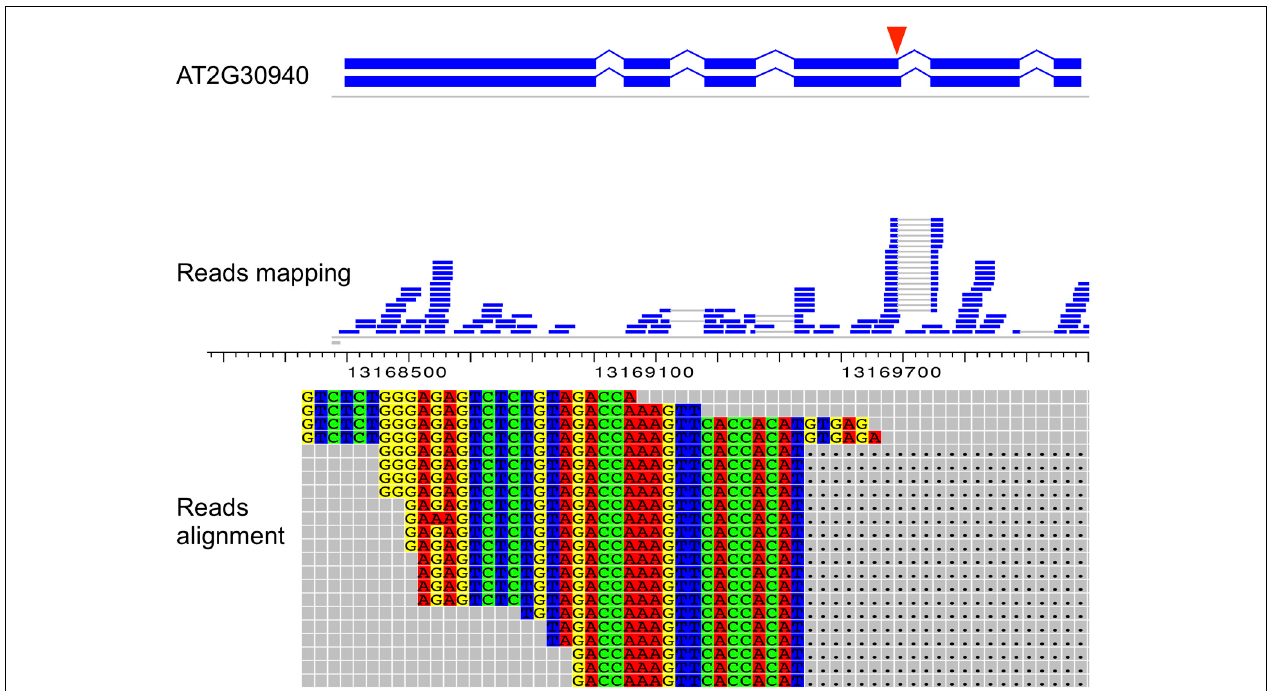
FIGURE 4 | An example of alternative spliced isoforms (of AT2G30940 ) expressed specifically at F12 stage. The fourth exons of the two isoforms end at different sites (pointed out in a red triangle) according to gene annotations in TAIR10, and this alternative donor event was further confirmed by PCR validation on flower tissues. Each bar (middle panel) represents a